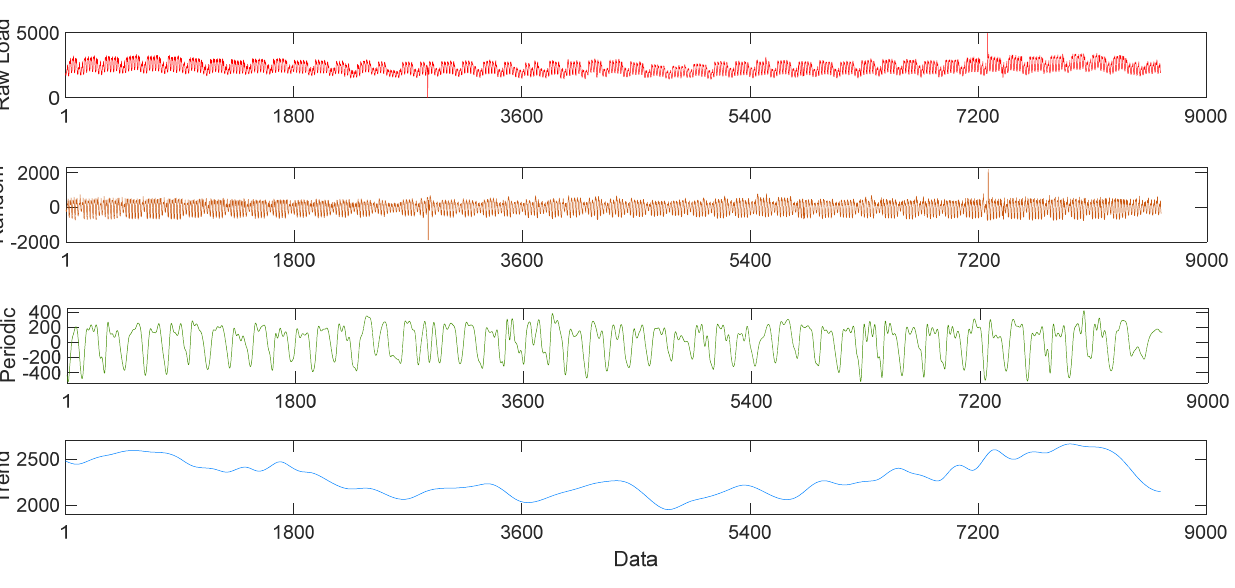
Figure 2. The reconstructed load series.